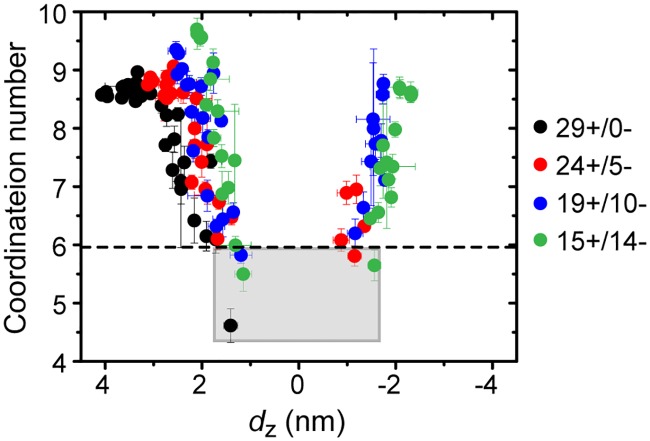
MUS end group coordination numbers as a function of the distance of each ligand from the bilayer midplane (dz).The average coordination number and average value of dz is plotted for each of the 29 MUS end groups for four ligand distributions. Error bars are computed using block averaging; the average error in dz is < 0.15 nm and the average error in the coordination number is < 0.25. The dashed line indicates the average coordination number of a ligand for which a reduced free energy barrier for flipping was calculated in prior work [36]. The points lying in the gray box correspond to ligands that are expected to flip on a timescale of seconds or less.